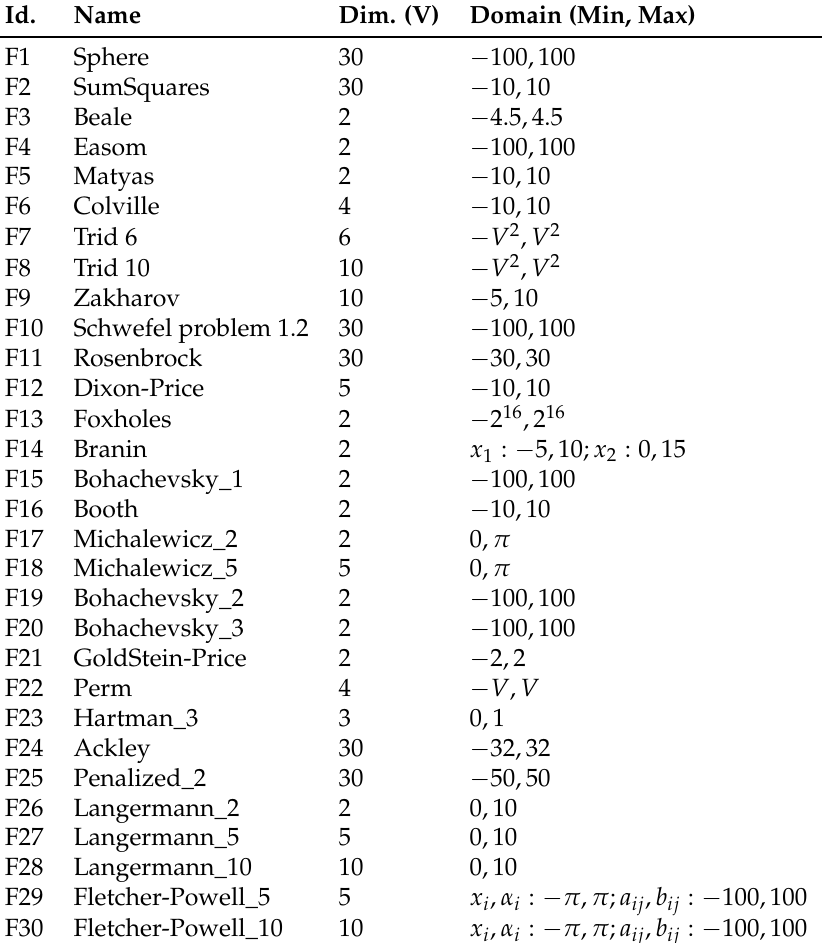
Table 1. Benchmark